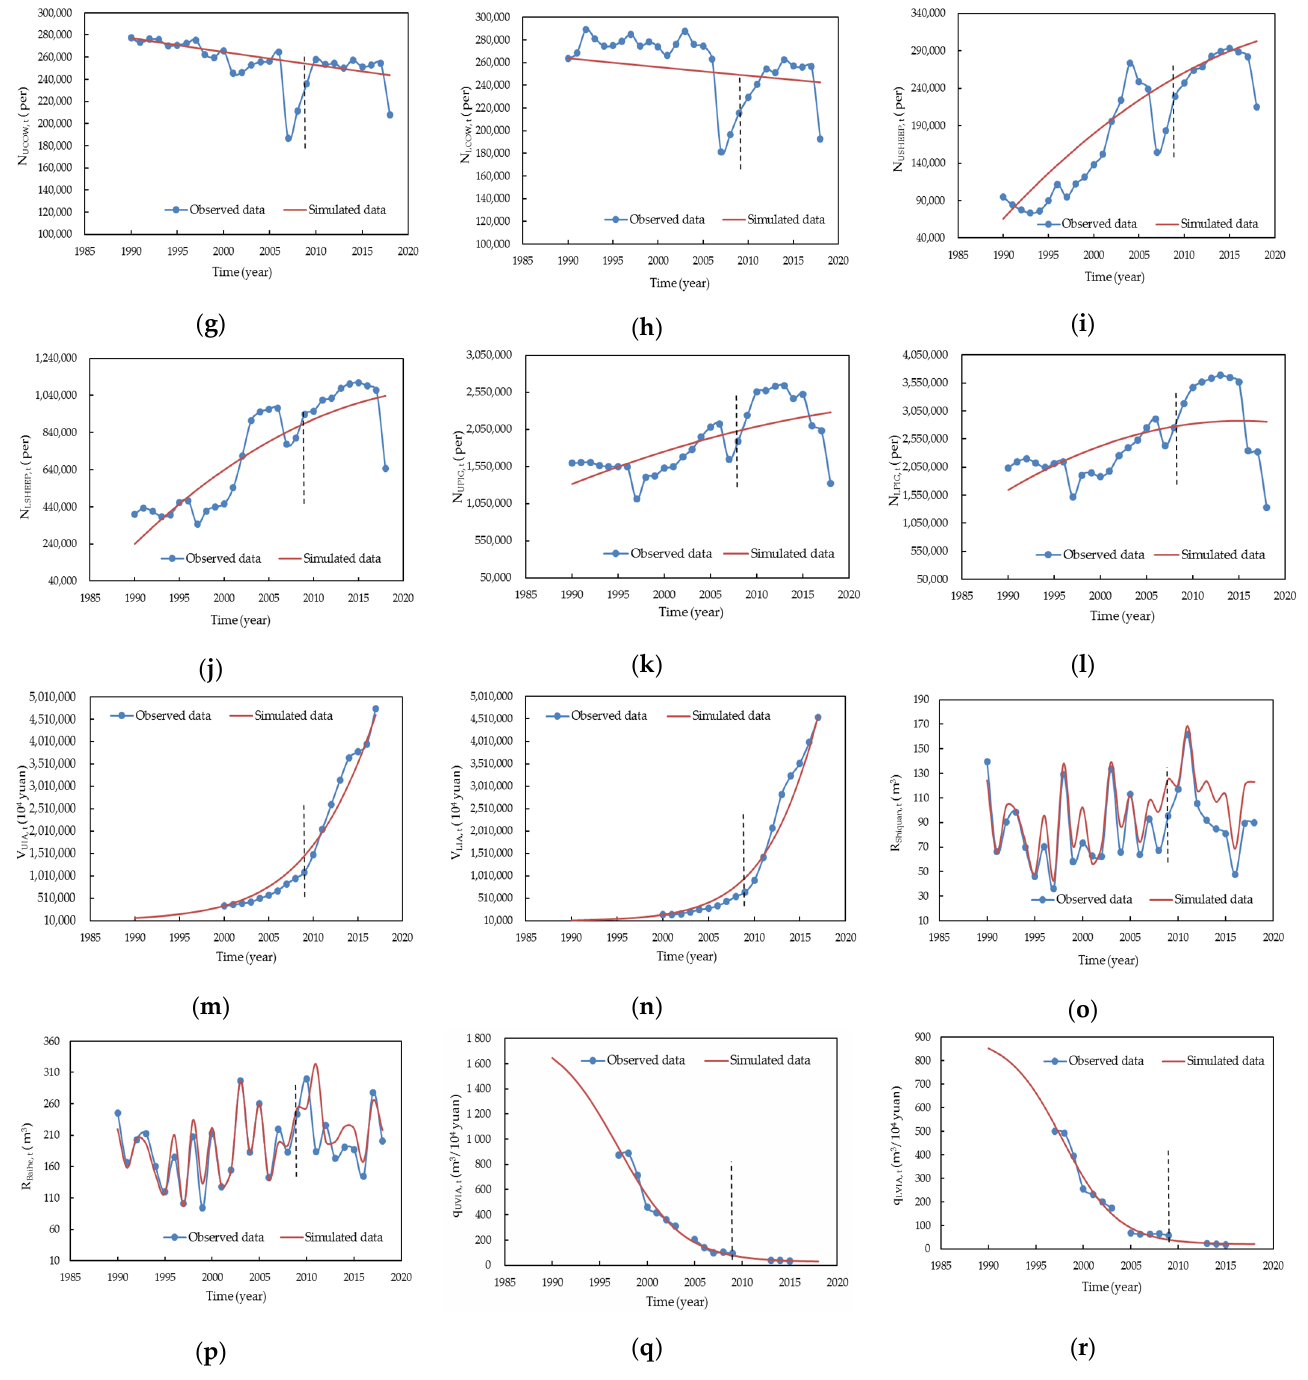
Figure 3. Simulated and observed values of variables. ( a ) Population in the upper section, ( b ) population in the lower section, ( c ) urban population in the upper section, ( d ) urban population in the lower section, ( e ) cultivable land area in the upper section, ( f ) cultivable land area in the lower section, ( g ) number of cows in the upper section, ( h ) number of cows in the lower section, ( i ) number of sheep in the upper section, ( j ) number of sheep in the upper section, ( k ) number of pigs in the upper section, ( l ) number of pigs in the lower section, ( m ) industrial added value in the upper section, ( n ) industrial added value in the upper section, ( o ) Shiquan runoff in the upper section, ( p ) Baihe runoff in the lower section, ( q ) water quota for industrial added value in the upper section, ( r ) water quota for industrial added value in the lower section.